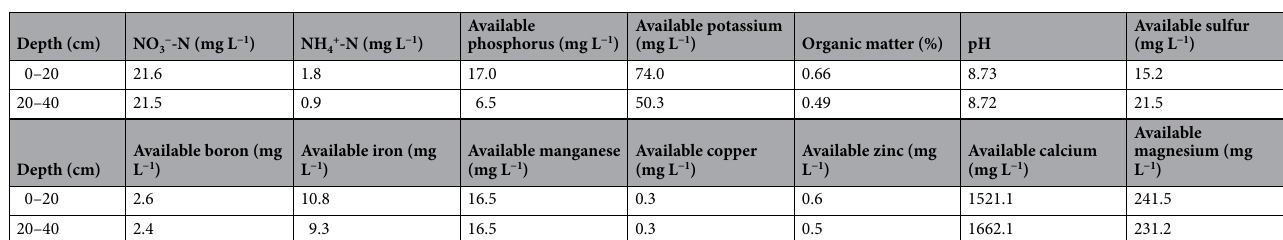
Table 1. Basic chemical properties of the soil at experimental site in